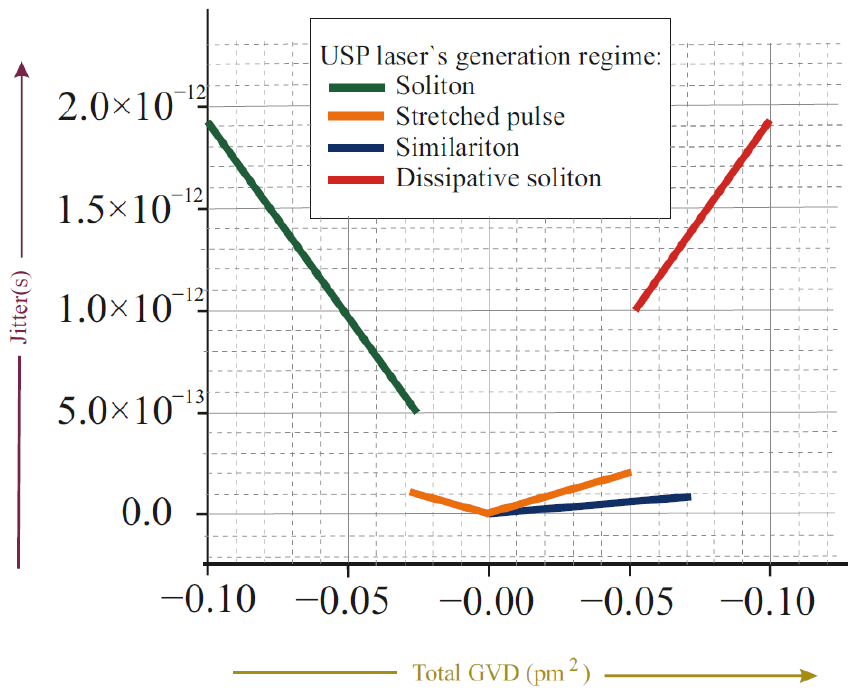
Figure 7. Calculation of the dependence of the jitter value on the total GVD of the USP laser resonator elements.